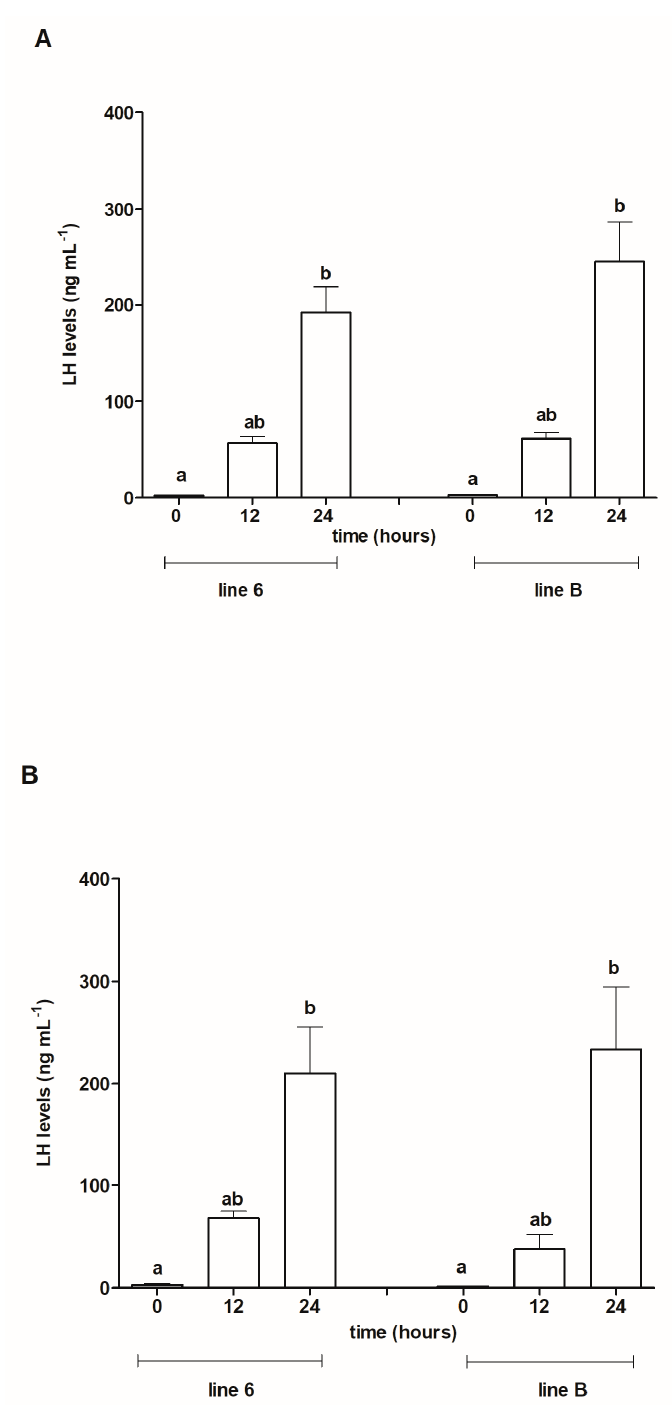
Figure 3. Plasma LH levels in blood samples taken from ovulated females from Polish line 6 and Lithuanian line B ( A ) and non-ovulated females from these lines ( B ) before the first injection of Ovopel (0 h) and 12 and 24 h post-injection (12 and 24 h). Different letters with ovulated and non-ovulated females of each line denote statistically significant differences between sampling times ( p ≤ 0.05). over time: in fish from line 6 from 2.95 ng mL − 1 (before treatment) to 209.78 ng mL − 1